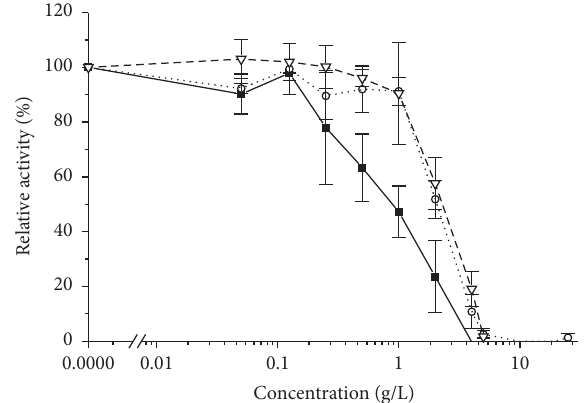
Figure 5: Effects of ILF (square), centrifuged ILF (circle), and filtered ILF (triangle) on the metabolic activity of HeLa quantified as relative WST activity. Growth control activity was set to 100% for each experiment. The recommended concentration for human consumption is 5g/L (1x). Values are expressed as mean ± 1,96 ∗ SEM ( 𝑛 = 3 ; for ILF filtered 𝑛 = 4